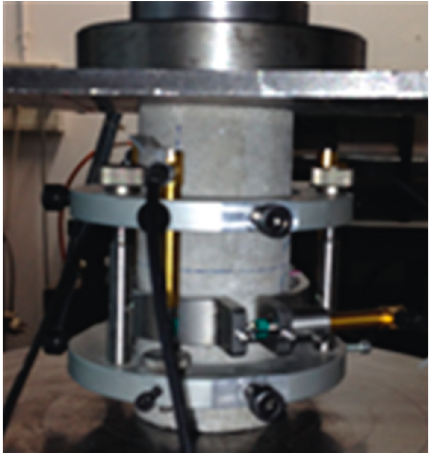
Figure 2: Specimen equipped with an extensometer during the compressive